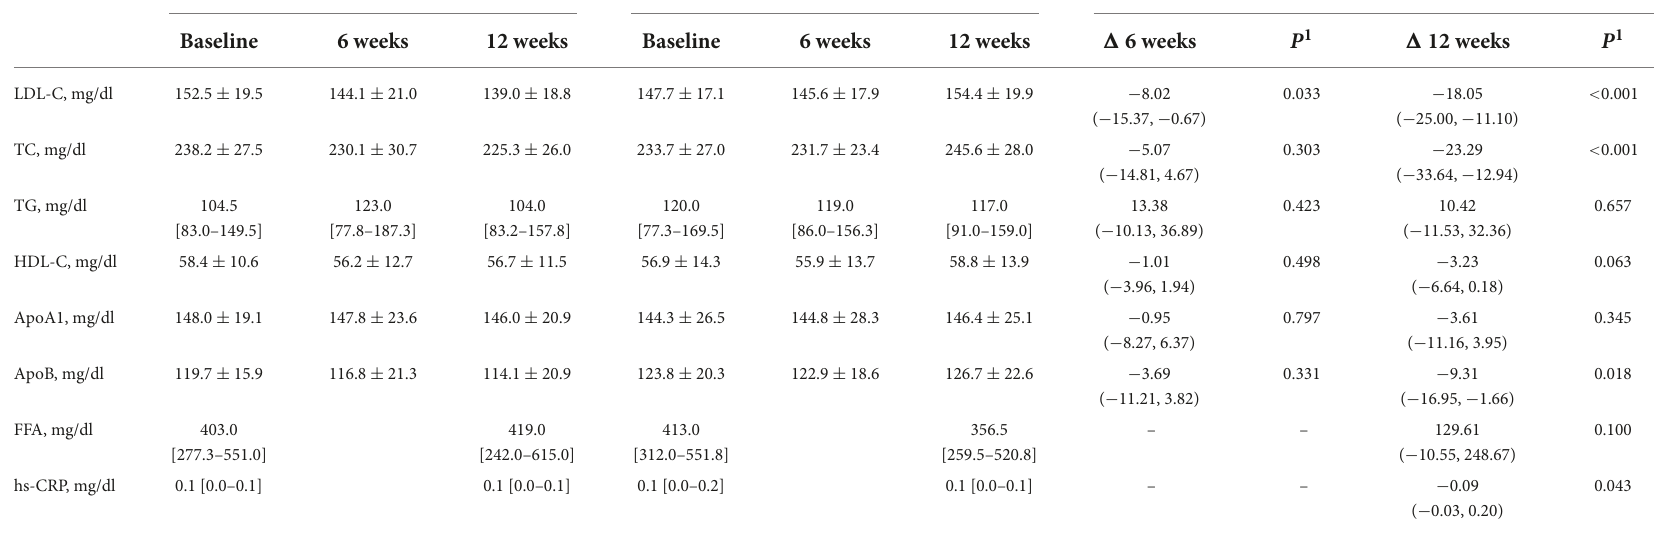
TABLE 3 Primary and secondary outcome measures of the two groups (intention-to-treat